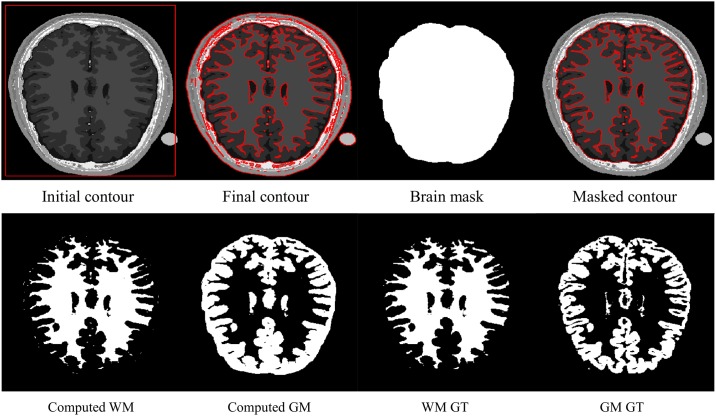
WM and GM regions computed with the proposed method and their respective ground truths.